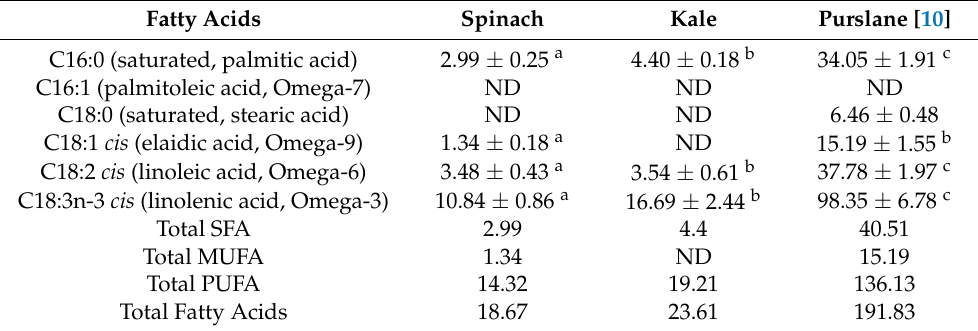
Table 1. Fatty acid content in spinach, kale, and purslane [10]. (Mean mg/100 g ± SD; n = 4), dry